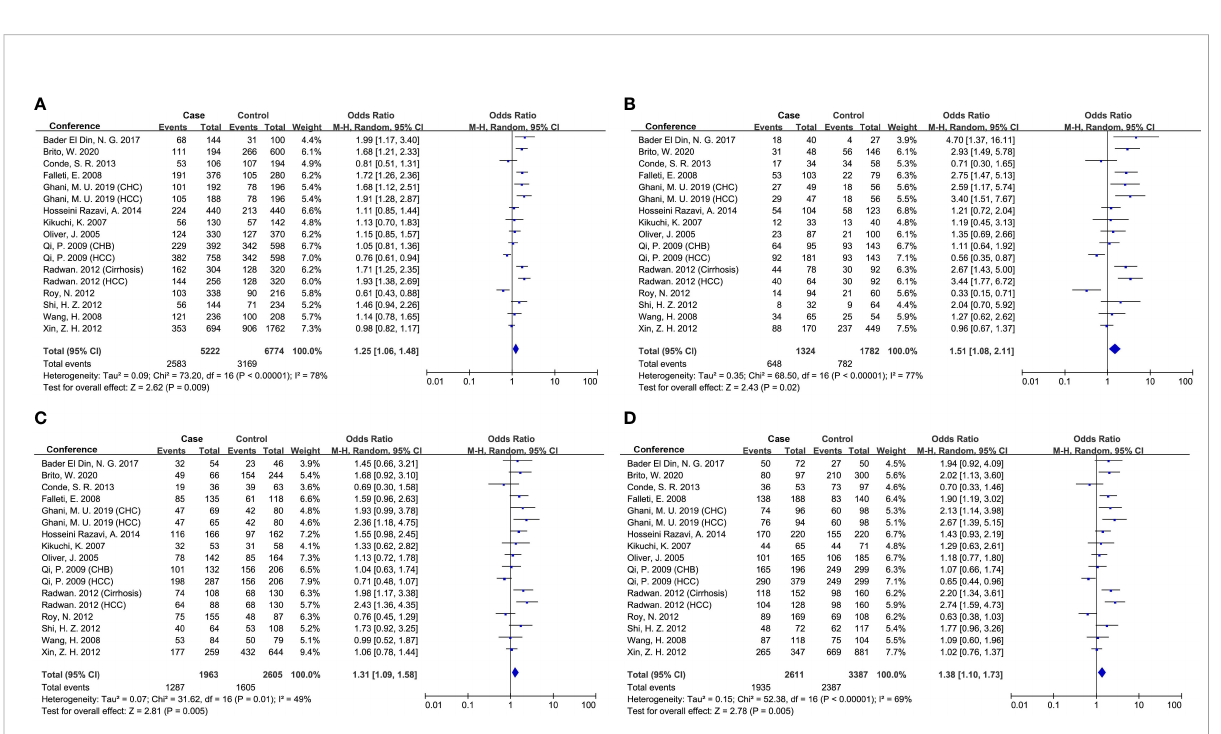
FIGURE 2 Forest plot of OR with 95% CI for associations between TGF- b 1 -509C/T polymorphism and CLD risk. (A) allele model, T vs C; (B) homozygote model, TT vs CC; (C) heterozygote model, CT vs CC; (D) dominant model, CT +TT vs CC. OR, pooled odds ratios; 95% CI, 95% con fi dence interval; T, Thymine; C, Cytosine.